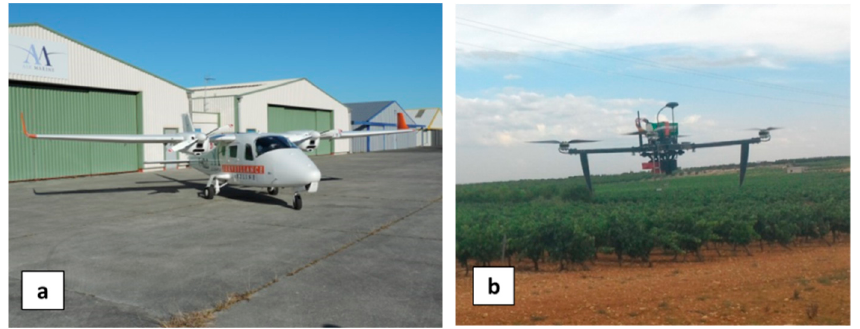
Figure 9. ( a ) Airplane platform (MAV) and ( b ) UAV platform equipped with two specific multispectral sensor systems.